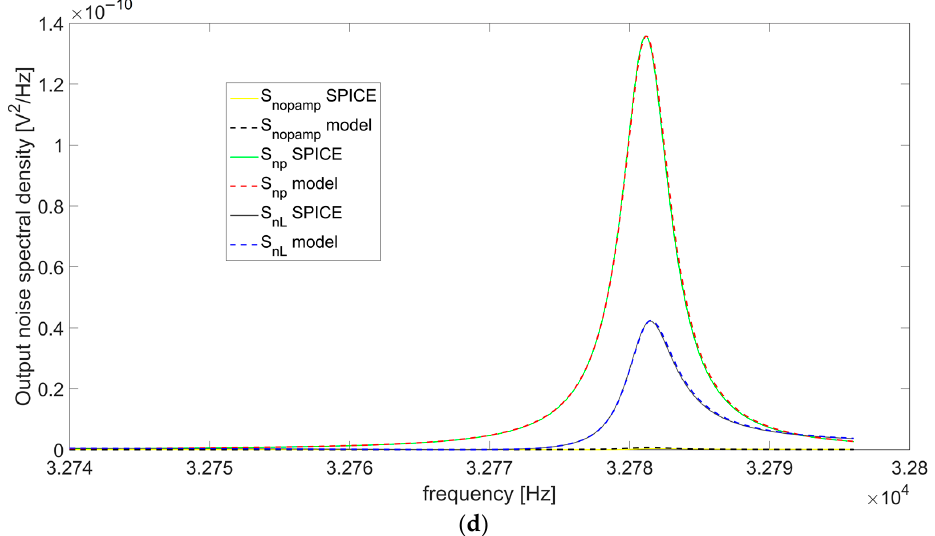
Figure 12. Contributions to the overall output noise spectral density due to the OPAMP and resistors R p and R L , for ( a ) R L = 100 k Ω , ( b ) R L = 500 k Ω , ( c ) R L = 6 M Ω , ( d ) R L = 20 M Ω : comparison between the results obtained with the analytical model and SPICE simulations.